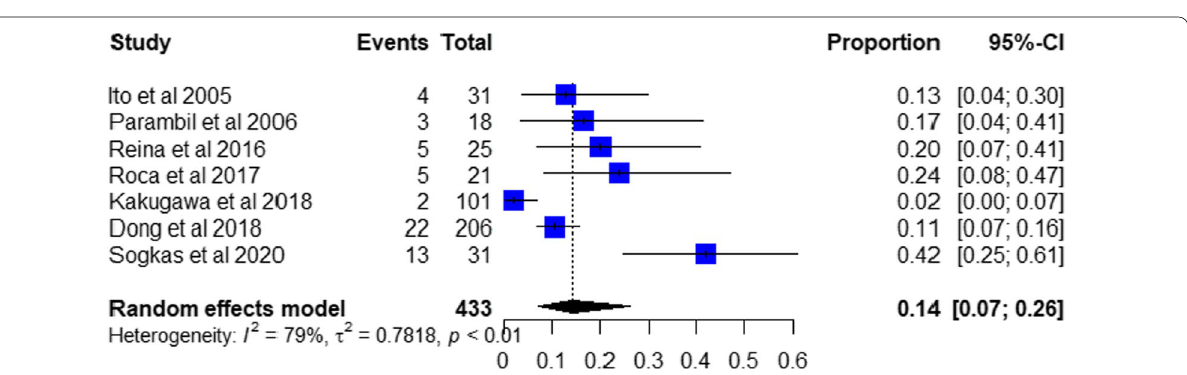
Fig. 6 Meta‑analysis of the usual interstitial pneumonia in patients with Sjogren’s syndrome